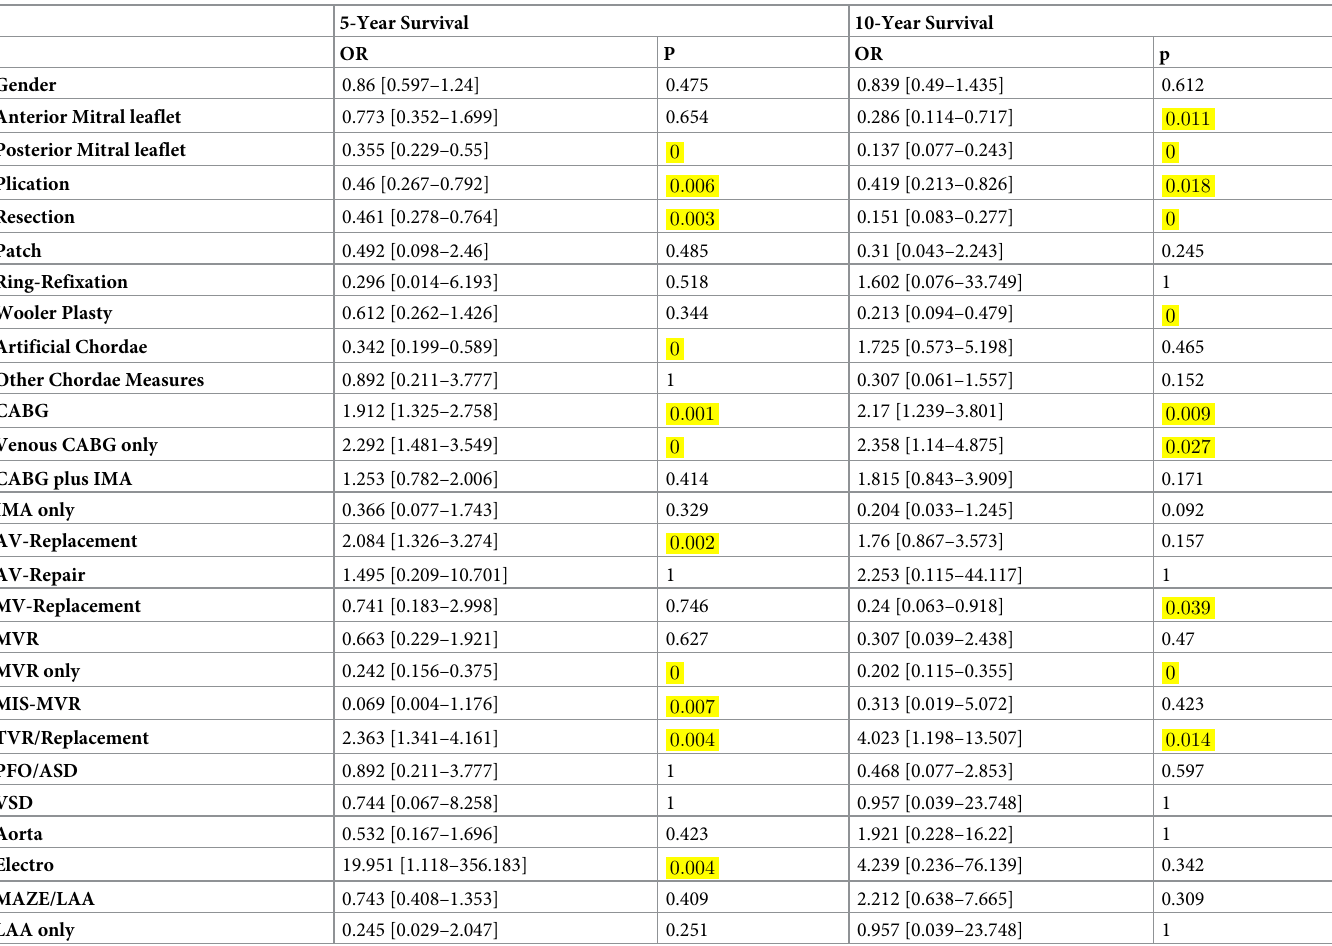
Table 5. Odds ratios of 5- and 10-year